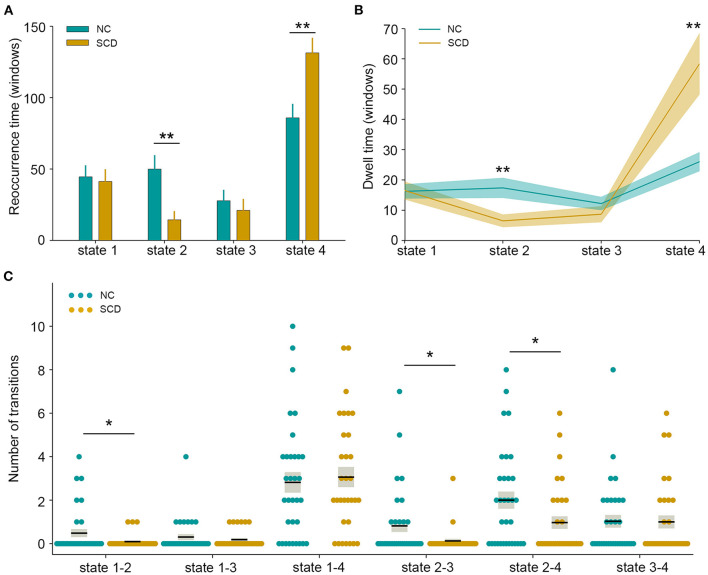
Temporal properties of dynamic functional connectivity states between the two groups. (A) Fractional windows in each state. (B) Mean dwell time in each state. (C) The number of transitions between pairs of states. The parameters of each individual in the normal control (NC) and subjective cognitive decline (SCD) groups are presented in blue and khaki dots respectively. The black lines indicate the mean values, and the light gray rectangles cover the data within one standard error above and below the mean. *p < 0.05; **p < 0.01.